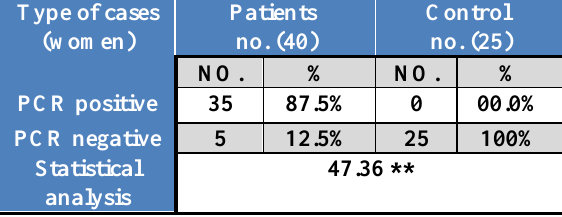
** Significant differences (P≤ 0.01). Tabel, 4: Nested PCR result for sheep blood samples.